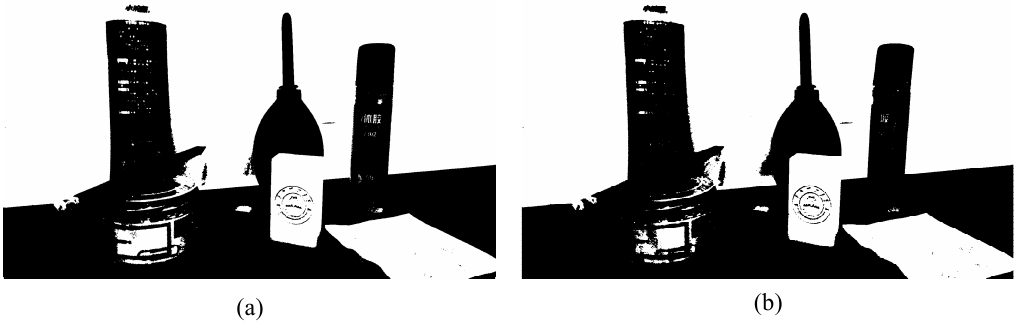
Figure 4. Different binarization segmentation results. ( a ) Conventional binarization segmentation; ( b ) binarization segmentation based on normalized cuts.